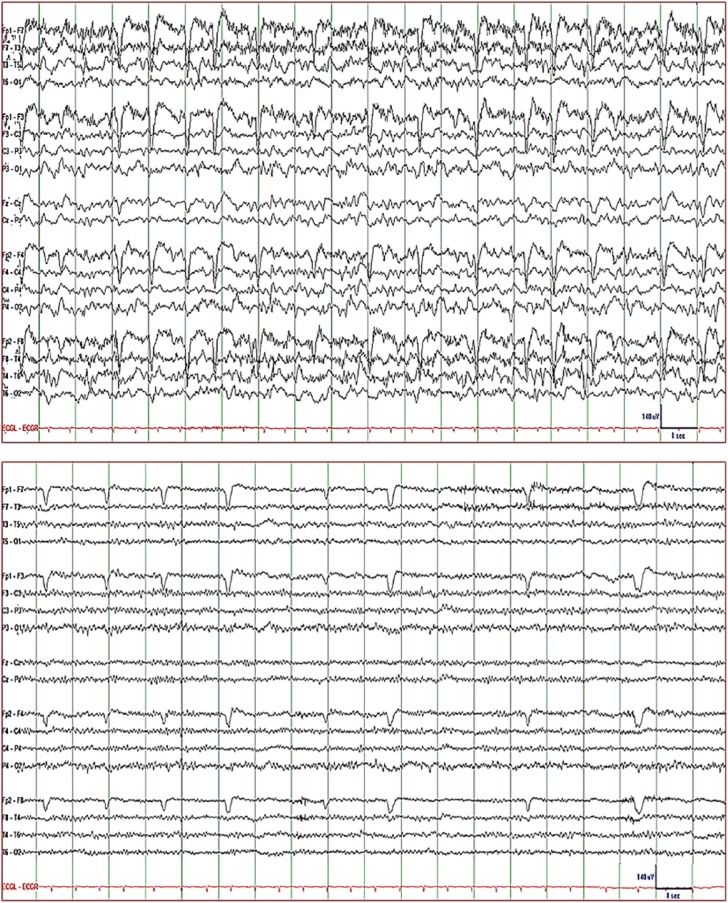
EEG of Patient 1. Top: generalized 2 to 3 Hz semirhythmic
delta activity superimposed on rhythmic theta and alpha activity with
patient delirious and perseverating consistent with NCSE and with patient
blinking every second on average (see eye blink artifacts) consistent with
oculoclonic status. Bottom: electrographic (and clinical as
seen on video) resolution of status epilepticus 3 days after dexamethasone
was added to conventional inpatient antiepileptic therapy. Display
parameters: longitudinal bipolar montage (from top to bottom:
left-mid-right-ECG), digital filter bandpass of 1 to 70 Hz, and 60-Hz notch
filter turned on; voltage-time scale is included in the tracing.